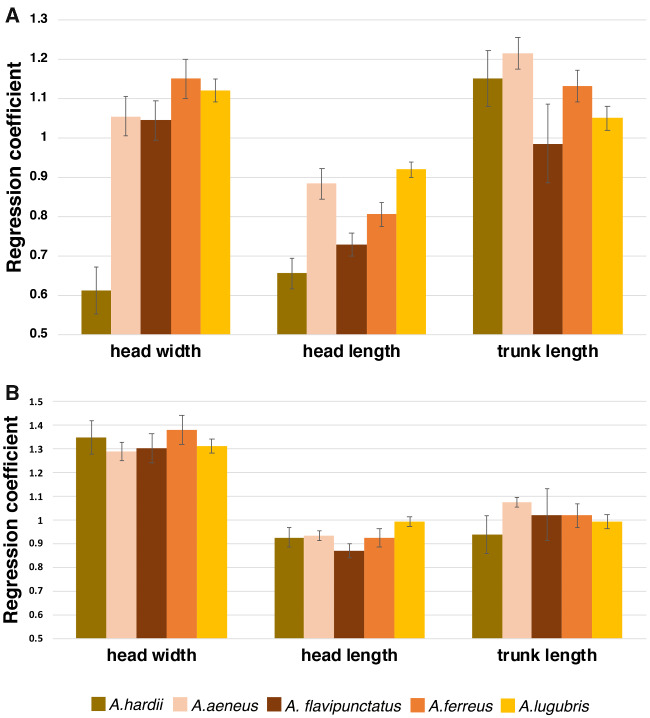
Interspecies comparisons of regression coefficients and standard errors within (A) female and (B) male A. hardii, A. aeneus, A. flavipunctatus, A. ferreus, and A. lugubris for HW, HL, and AG length regressed against SVL.